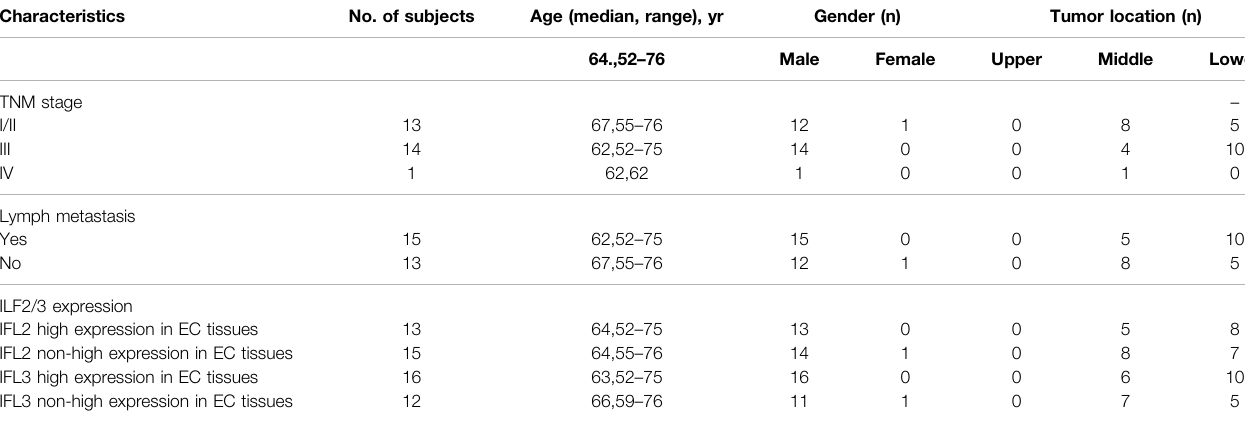
TABLE 1 | Summary of clinical and demographic features for study subjects and tumor characteristics.